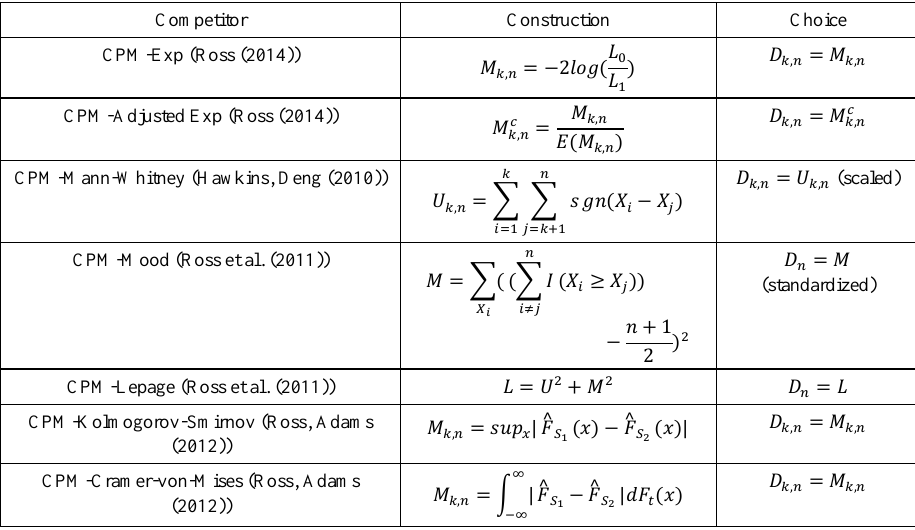
Table 1. Choices for the two-sample D k,n statistics under the CPM framework (Hawkins et al. (2003)[15]).